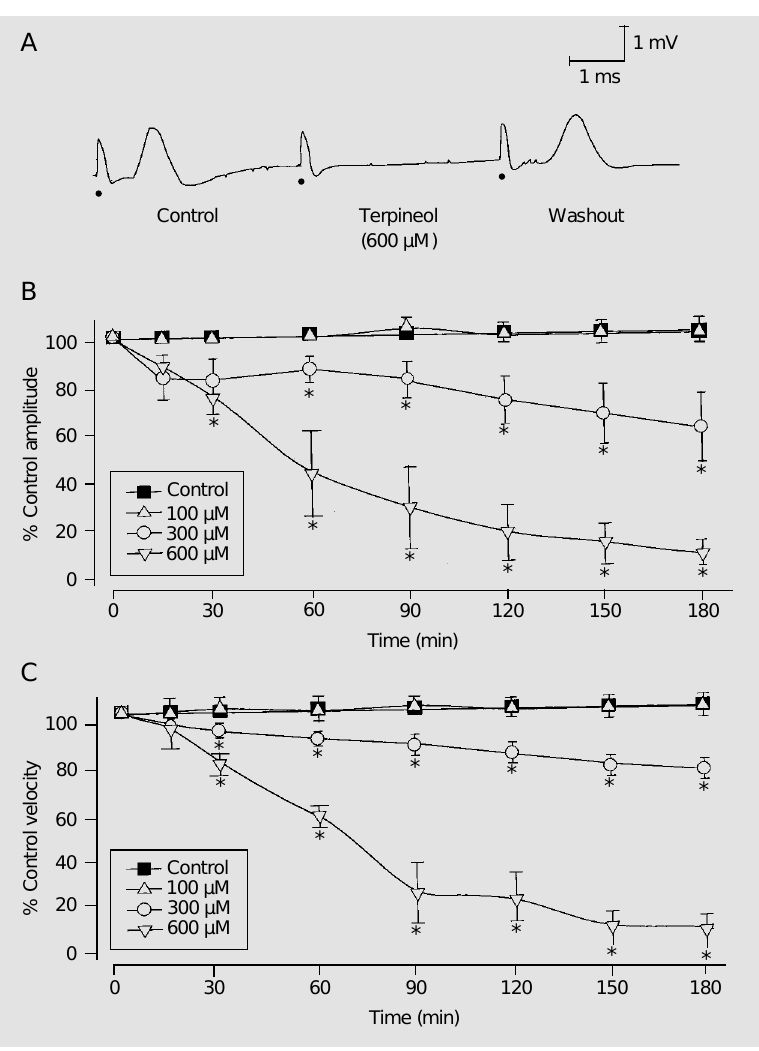
Figure 1. Time course of the effects of terpineol on peak-to-peak amplitude and conduction velocity of the compound action potential (CAP) of rat sciatic nerve. Panel A shows representative CAP tracings under control conditions and at the 180th min of nerve exposure to 600 µM terpineol and at 180 min washout. The dot below each tracing shows the time of stimulation. Quantification of terpineol-induced effect on peak-to-peak ampli- tude and conduction velocity is shown in panels B and C , respectively. Data are reported as mean ± SEM. The number of experiments was 5 in all cases, except for conduction velocity for 600 µM terpineol at 150 and 180 min where N was 4 since blockade was complete in one of the experiments. *P<0.05 compared to control (ANOVA and contrast technique